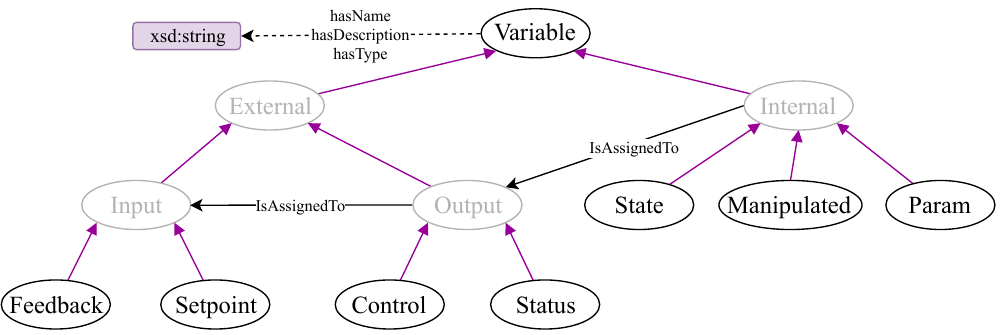
Figure 5. Graph representation of variables’